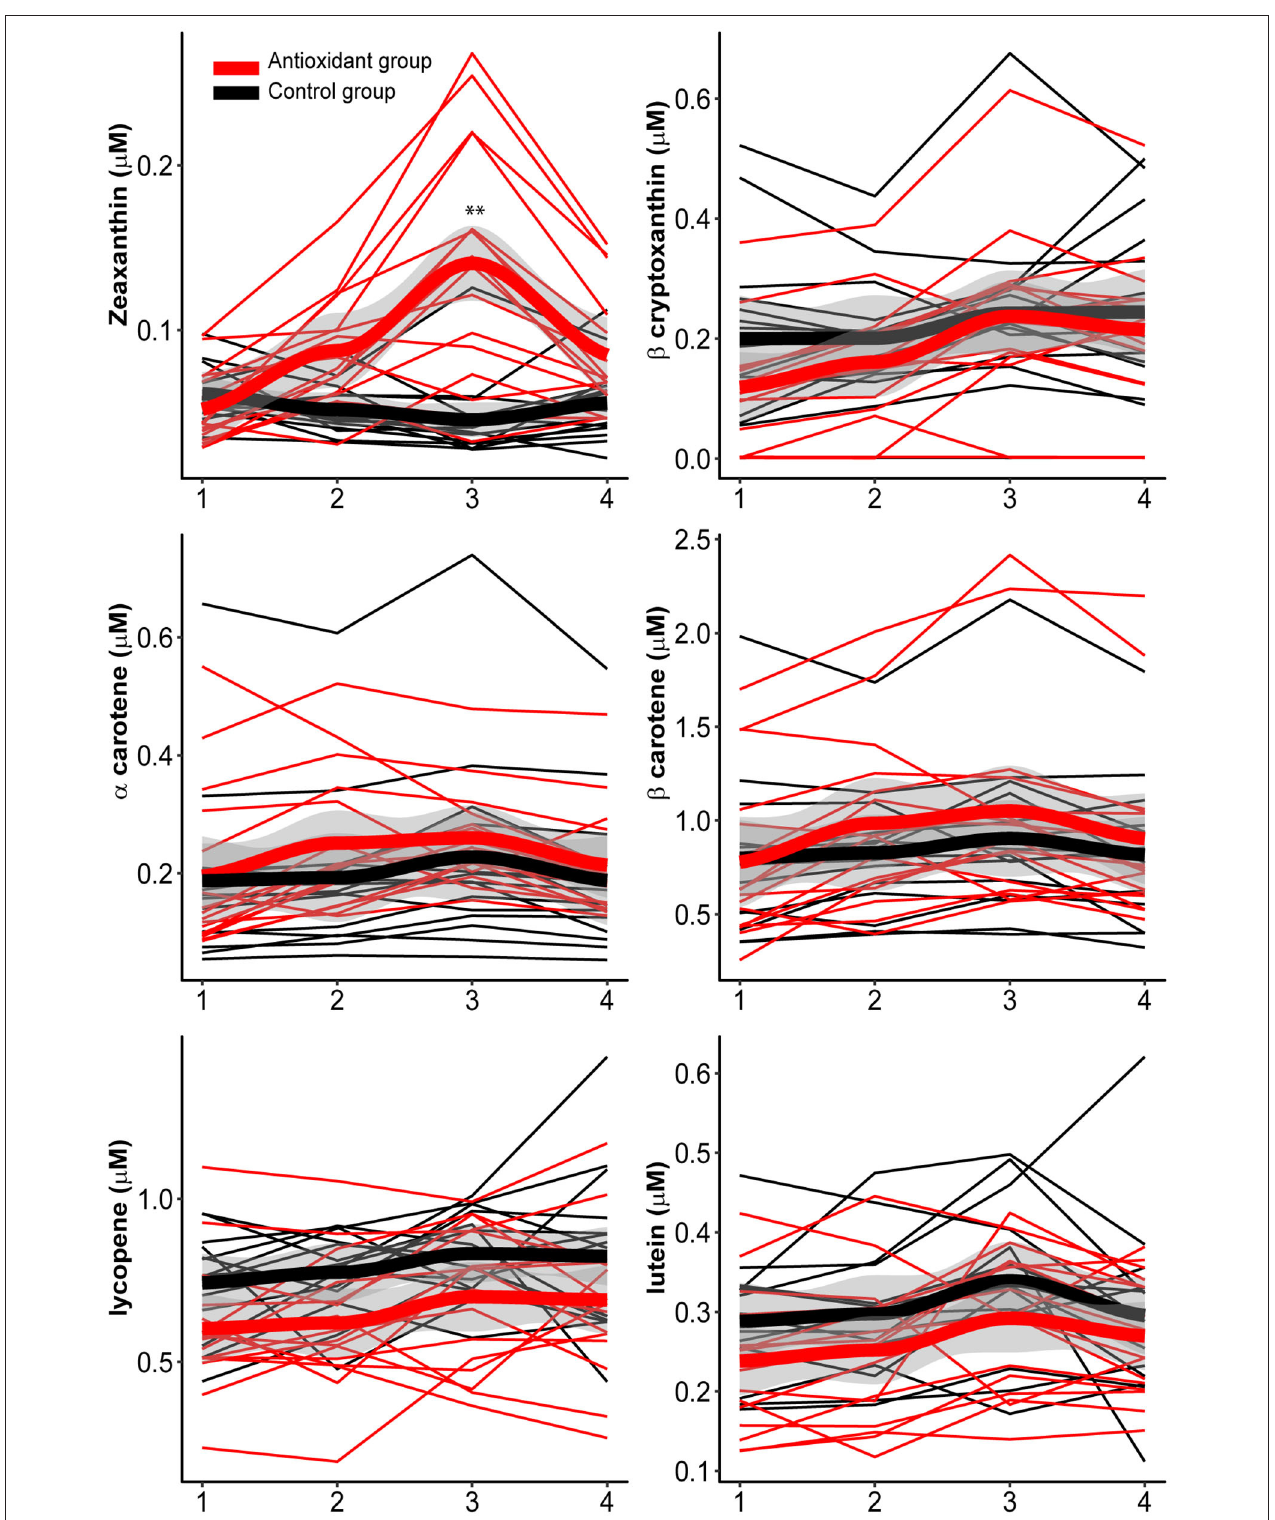
FIGURE 7 | Carotenoid (zeaxanthin, β -cryptoxanthin, α -carotene, β -carotene, lycopene, and lutein) concentration pre-altitude (1), on day 5 (2), and 18 (3) at altitude (2,320m), and post-altitude (4) in the antioxidant and control group. **mixed model analyses indicate significant time x group effects for zeaxanthin. The “qplot” function in the R (R for statistical computing, Vienna, Austria, Version 3.6.1.)—packages “ggplot2” and the function “geom smooth”.